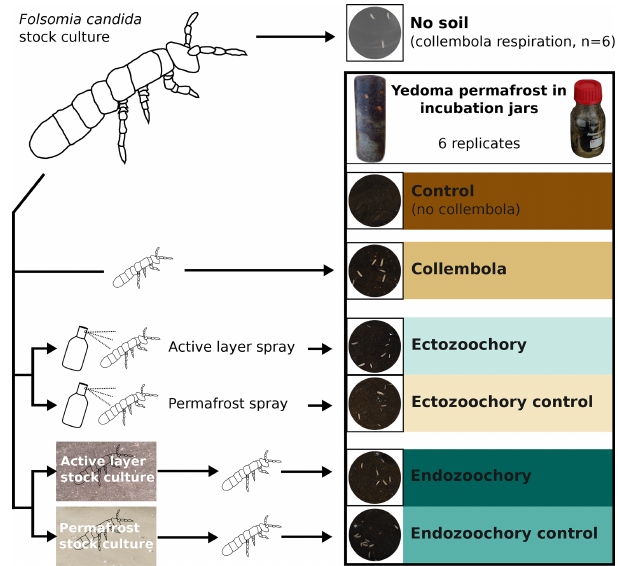
Figure 1. Summary of the experimental design. Folsomia candida Collembola were grown in a stock culture on gypsum and fed with yeast and then subjected to different treatments before being in- oculated into jars filled with Yedoma permafrost sediment (30– 80 individuals per jar). Ectozoochory was assessed by spraying the Collembola with soil suspensions, while endozoochory was as- sessed by growing Collembola in stock cultures supplemented with soil. The jars were incubated in the dark for 25d at 10 ◦ C; CO 2 pro- duction was measured throughout the incubation period, and bacte- rial community composition was determined at the end of the incu-